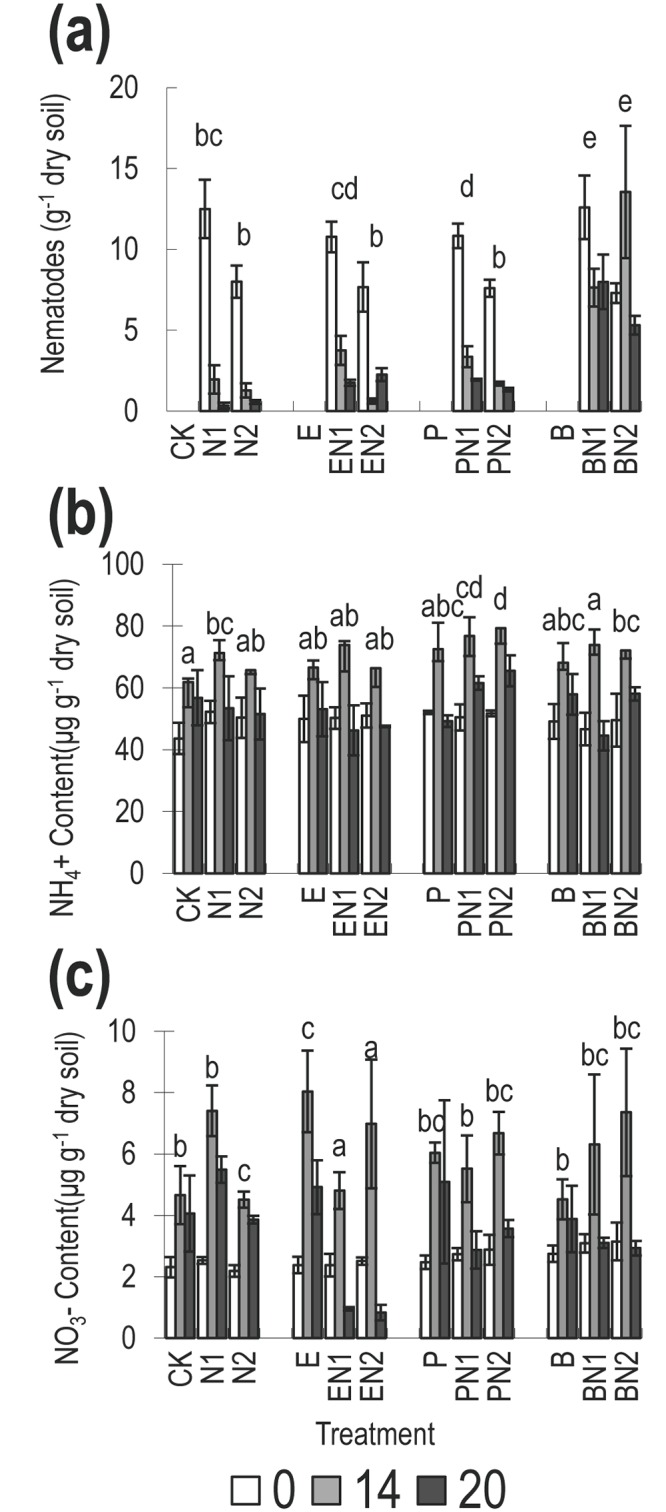
Dynamic of soil mineral nitrogen in the ‘inoculation’ experiment; (a) nematode abundance, (b): NH4+, (c) NO3-, before and 14 and 20 days after inoculation of sterilised soil with: CK = sterilized soil; N1 = Cephalobus; N2 = C. elegans; E = E. coli; EN1 = E.coli and Cephalobus; EN2 = E and N2; P = Pseudomonas; PN1 = P and N1; PN2 = P and N2; B = Burkholderia; BN1 = B and N1; BN2 = B and N2.